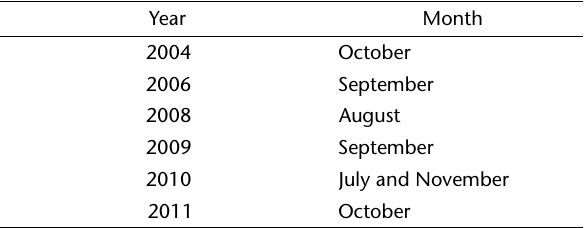
Table I. Month of calling activity of Proceratophrys appendiculata per year in the period of 2004 to 2012. Breeding site not visited in the years of 2005 and